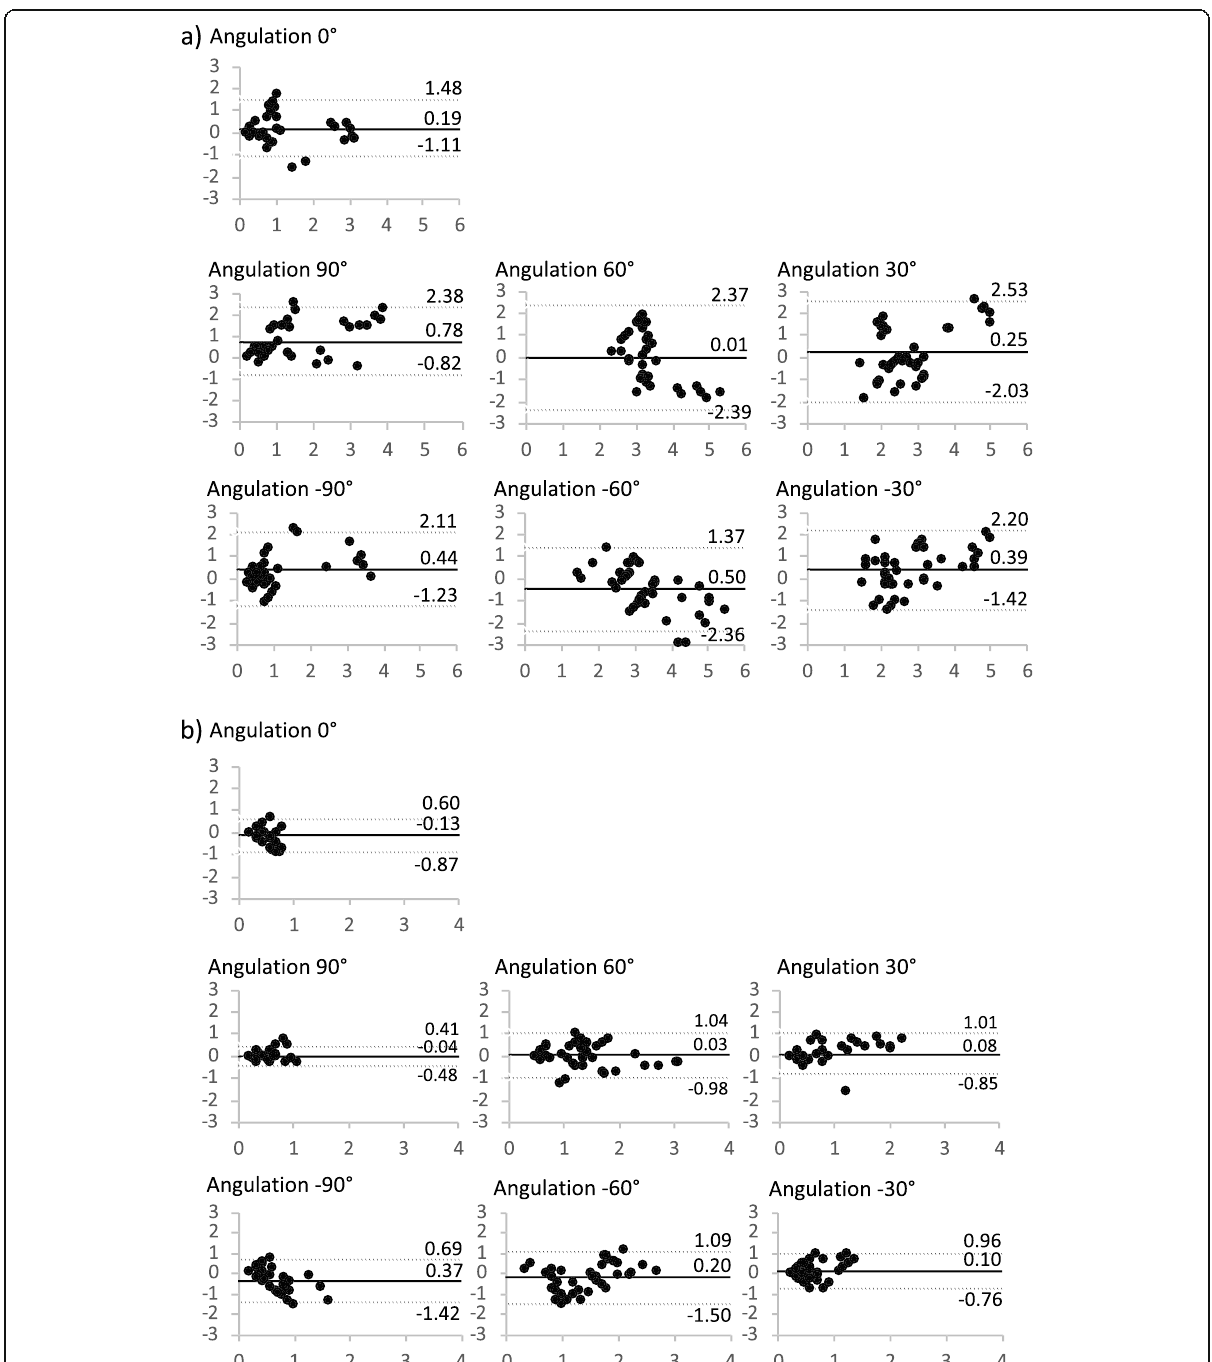
Fig. 5 A Bland – Altman analysis of differences between imaging modalities for FI. For each c-arm angulation, differences between the centerline deviation between FI using the CTA and the MRA data for a 2D-3D registration and b 3D-3D registration were assessed. Means (straight line) and limits of agreement (mean ± 1.96*standard deviation; dashed line) are given. Overall, the spread of values was acceptably small, with the exception of individual values showing differences of > 3 mm using 2D-3D registration. 3D-3D registration was superior to 2D-3D registration regarding both the spread of values and the quality of